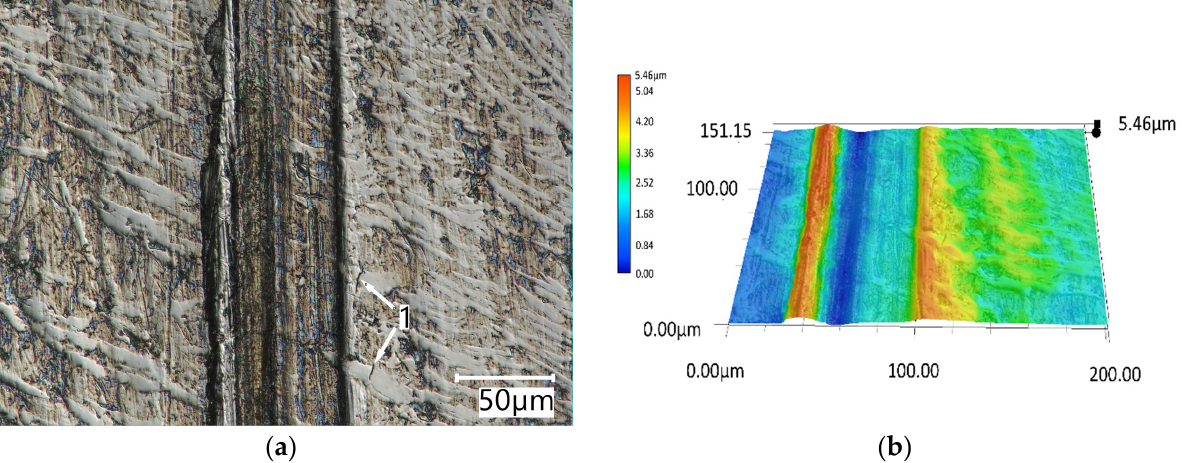
Figure 14. The surface of PMFe60P padding weld worn in the medium soil ( a ) and a surface profile of PMFe60P padding weld ( b ): 1—cracks in the carbide phase at the groove boundary. Optical light microscopy.